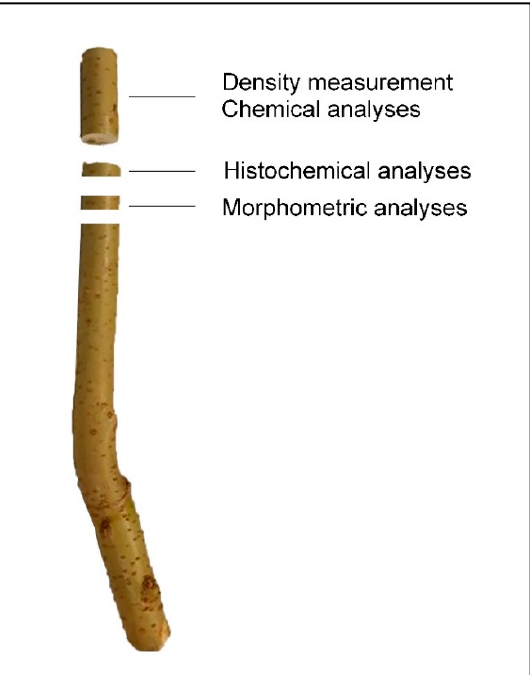
Figure 1. Overview of sampling from the basal regions of the S. viminalis stems.